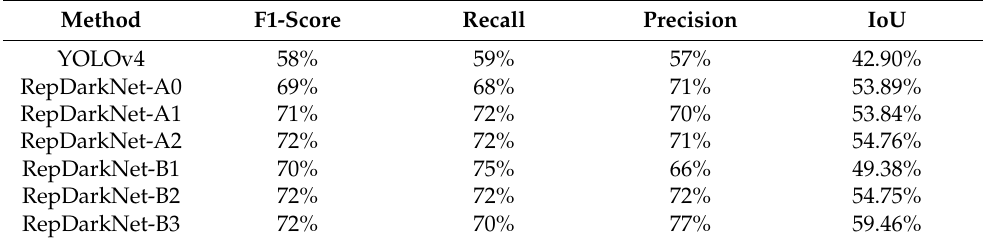
Table 2. Comparison of recall, precision, F1-score, and IoU by methods.